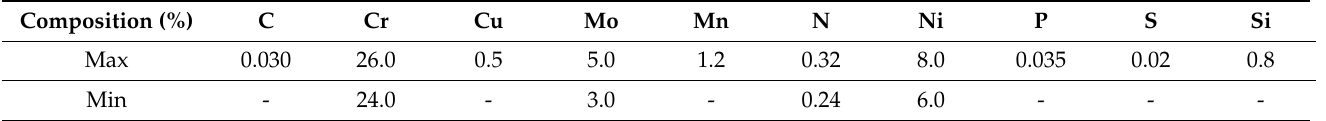
Table 1. Chemical composition of UNS S32750 super duplex